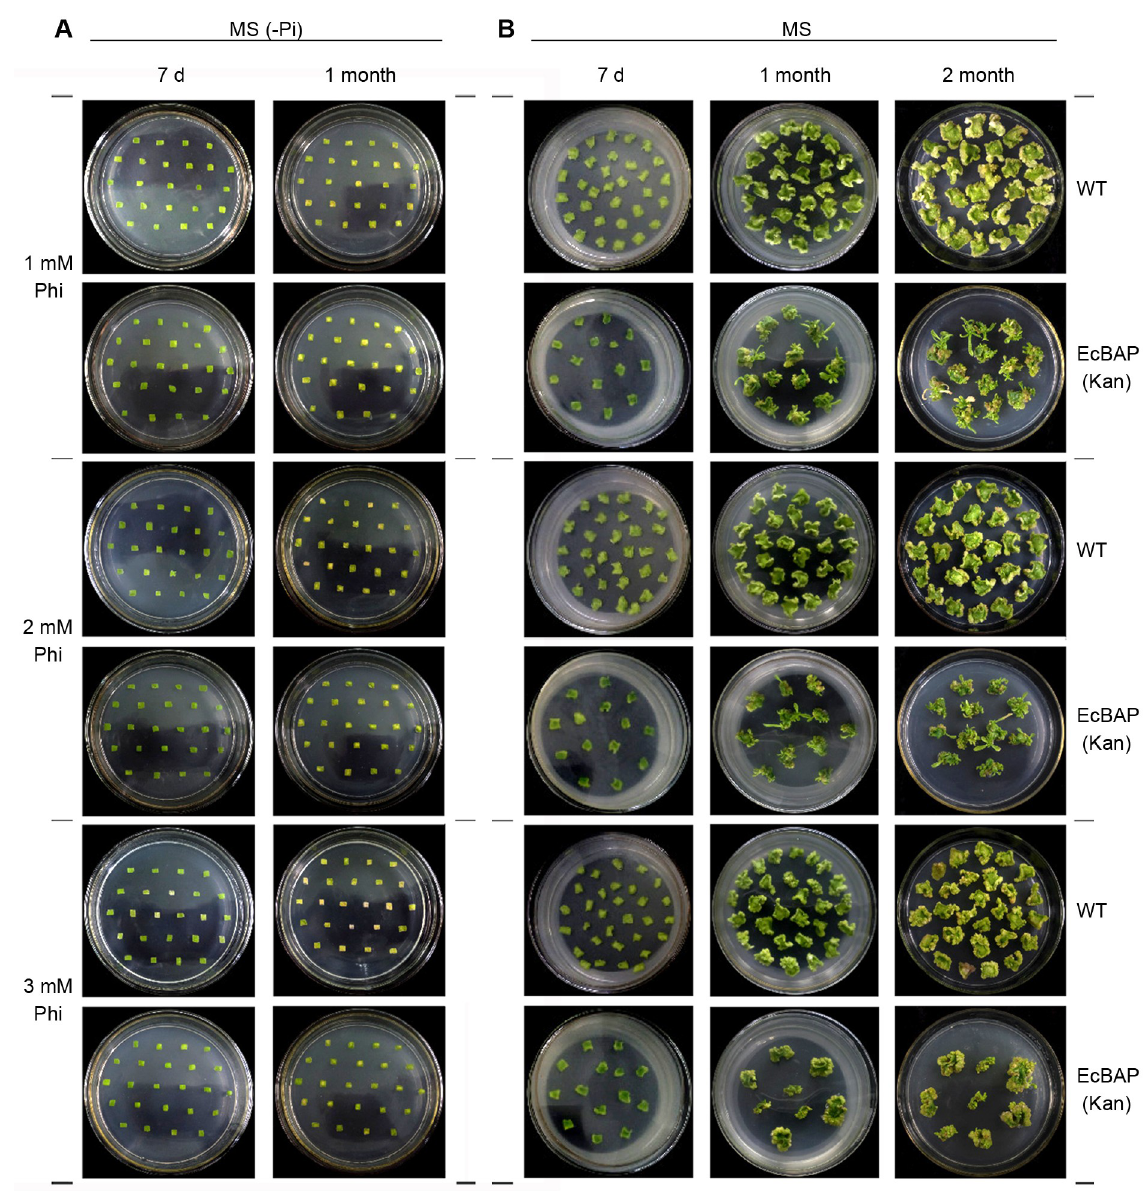
Fig 3. Leaf explant regeneration test of EcBAP(Kan) transgenic tobacco under low to moderate Phi stress. Small leaf pieces (0.5 cm × 0.5 cm) of WT and EcBAP(Kan) transgenic tobacco were pairwise laid on (A) MS (-Pi) or (B) standard MS medium, containing Phi of low to moderate concentrations (1, 2, 3 mM). After 7 days, 1 month, and even 2 months, the differentiation/regeneration status of these leaf explants under Phi stress were photo-recorded and compared between WT and EcBAP(Kan) transgenic tobacco.